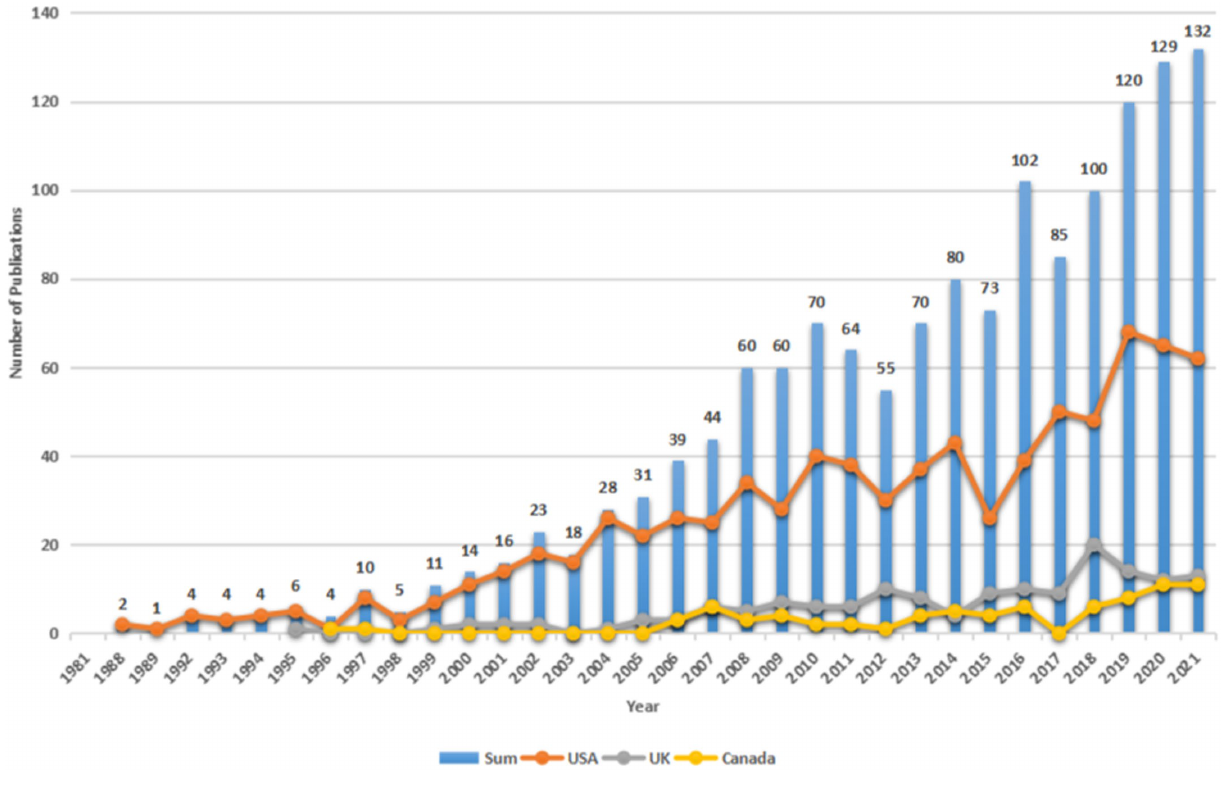
FIGURE 2 | Number of yearly publications, and growth curves in the top 3 countries in the studies of expressive writing during 1981–2021. The bar represents the annual number of total publications worldwide. The legends of the United States, the United Kingdom, and Canada represent that they are the top 3 most productive countries and their performance was illustrated by the three curved lines overlayed on the charts.